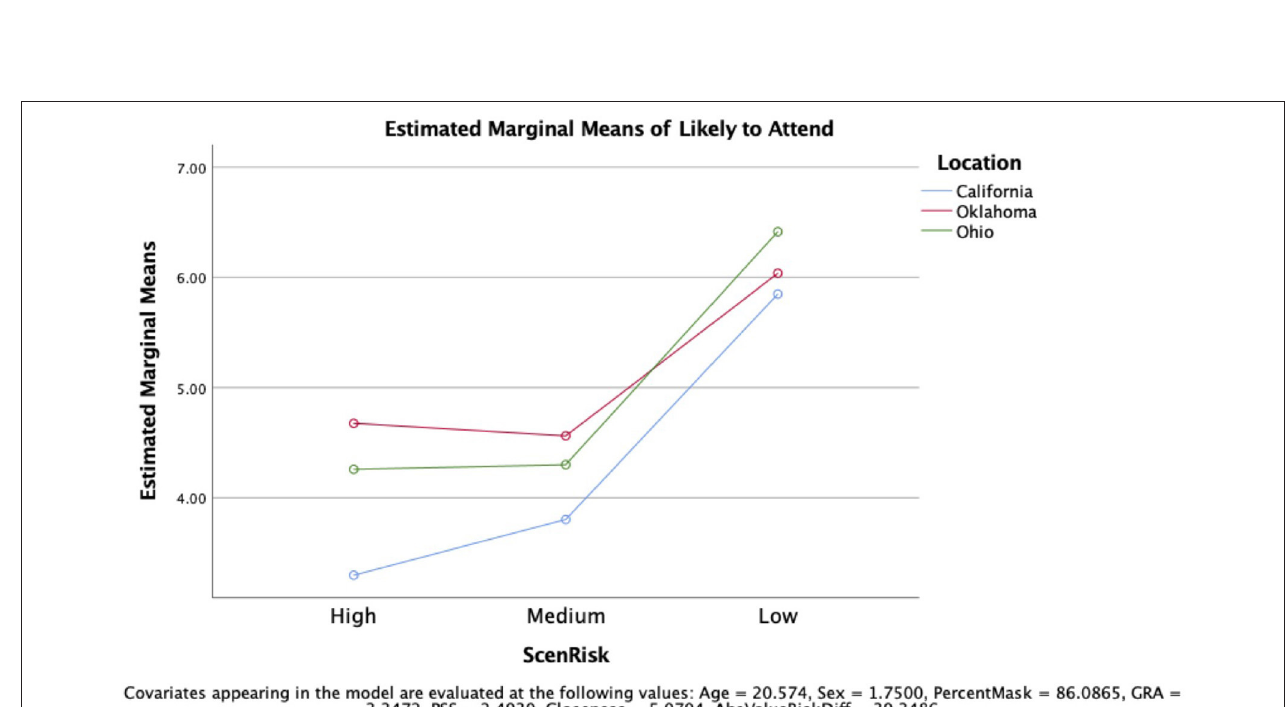
FIGURE 1 | Interaction of risk level and location of data collection to predict comfort attending an event during the COVID-19 pandemic.